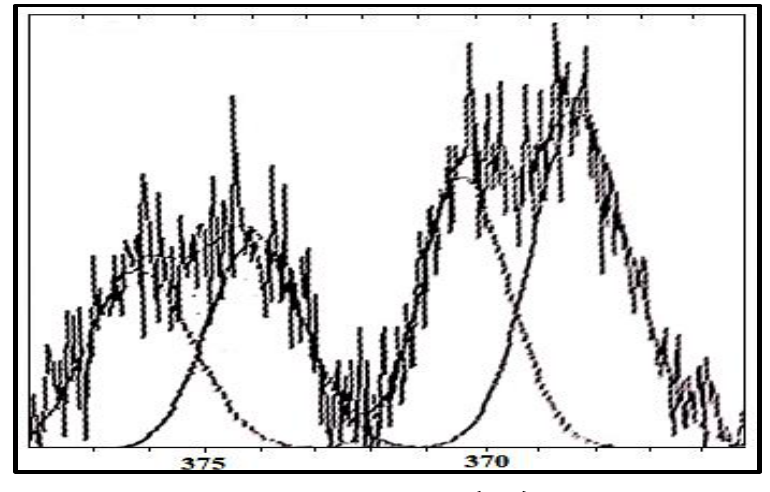
Figure 3. XPS spectrum of H 31 /AgNPs5% composite.